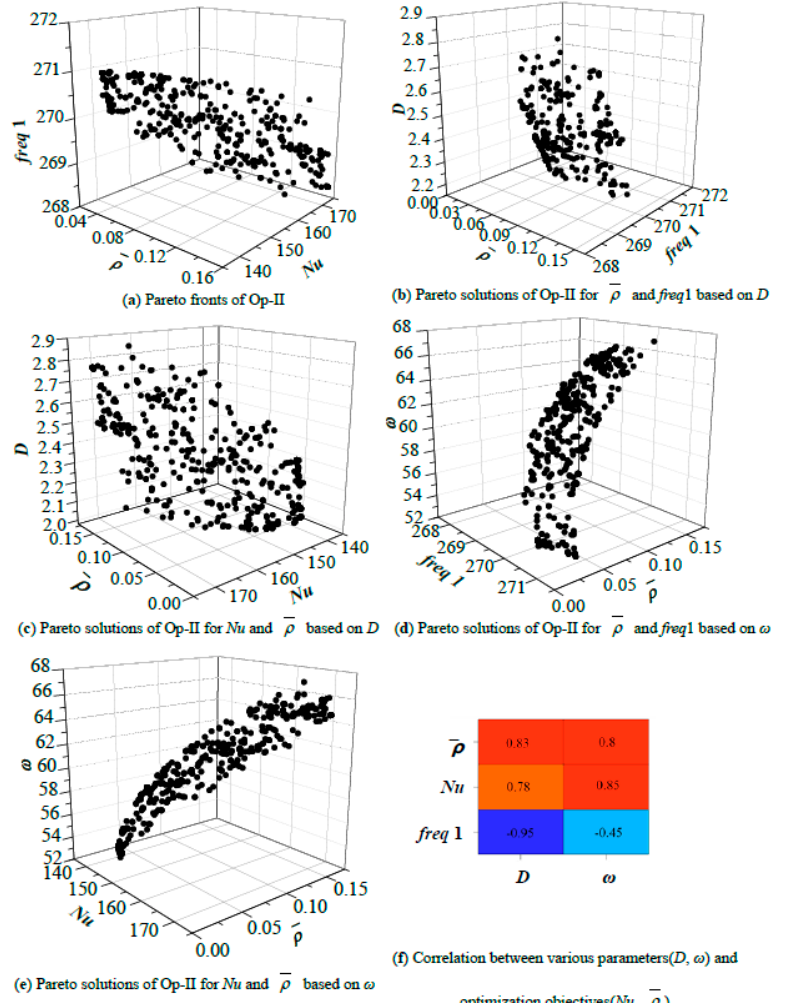
Figure 9. Overall and single sensitivity analysis for Op-II of XLS: ( a ) Pareto fronts of Op-II; ( b ) Pareto solutions of Op-II for ρ and freq 1 based on D ; ( c ) Pareto solutions of Op-II for Nu and ρ based on D ; ( d ) Pareto solutions of Op-II for ρ and freq 1 based on ω ; ( e ) Pareto solutions of Op-II for Nu and ρ based on ω ; and ( f ) correlation between various parameters ( D , ω ) and optimization objectives ( Nu , ρ ) .